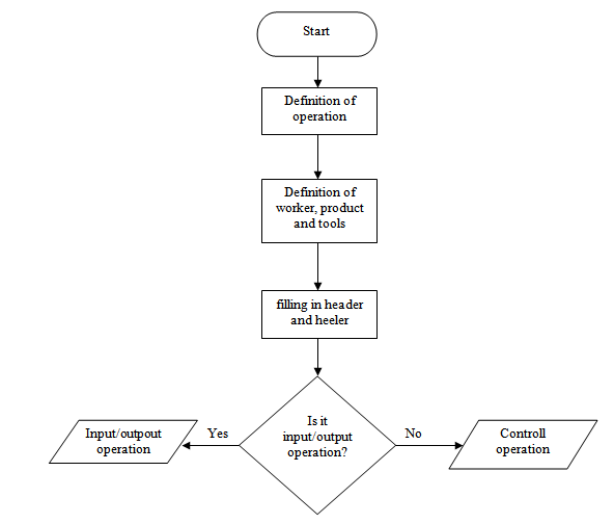
Figure 7: First part of flowchart.